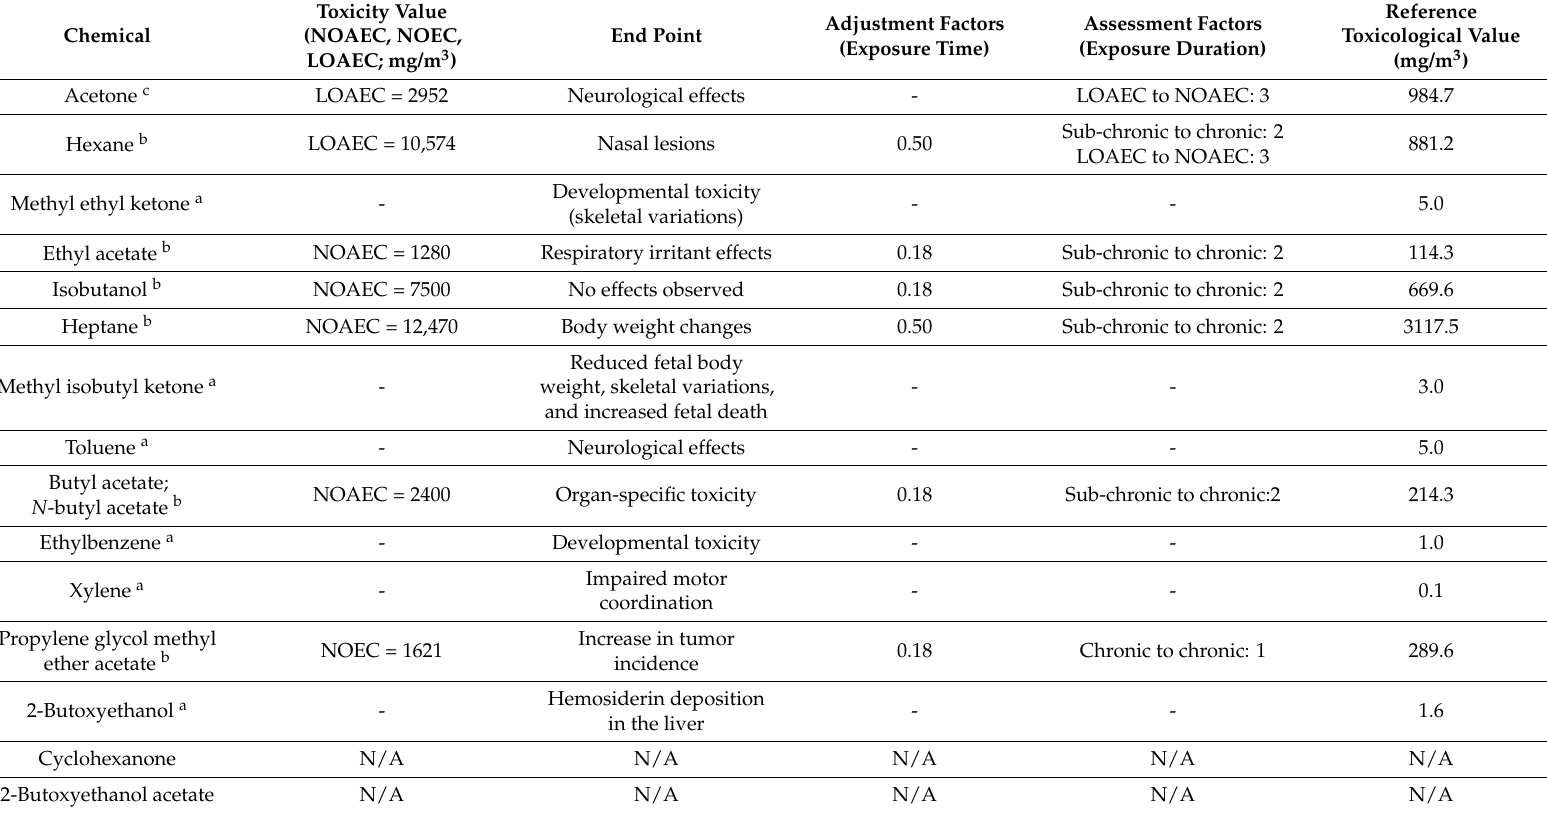
Table 4. Summary of toxicological information for target